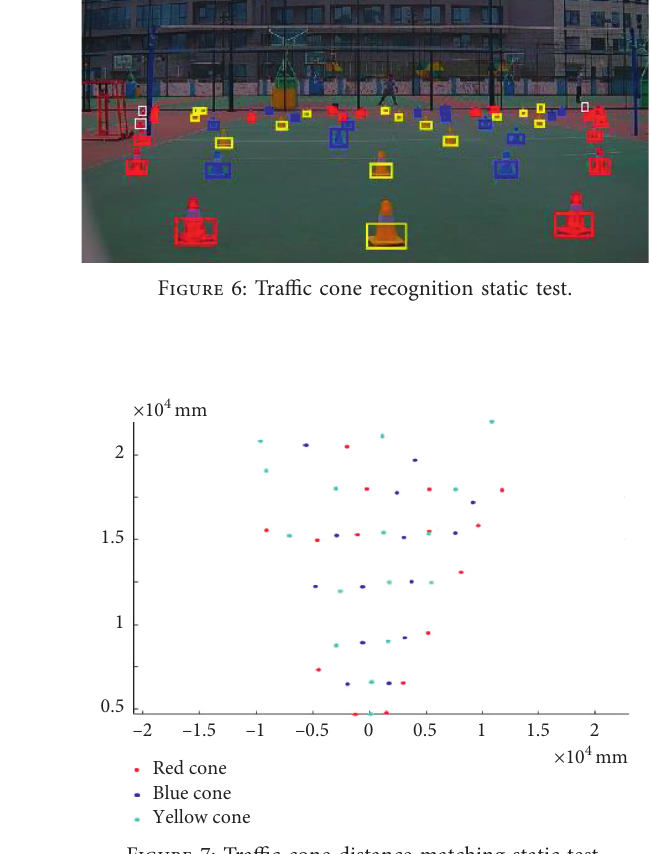
Figure 7: Traffic cone distance matching static test.